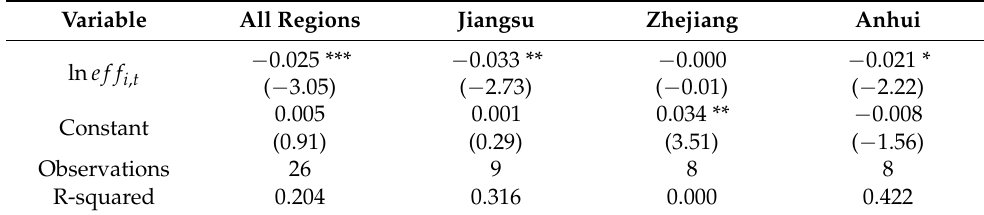
Table 5. Absolute β Convergent Regression Results of Each Region.